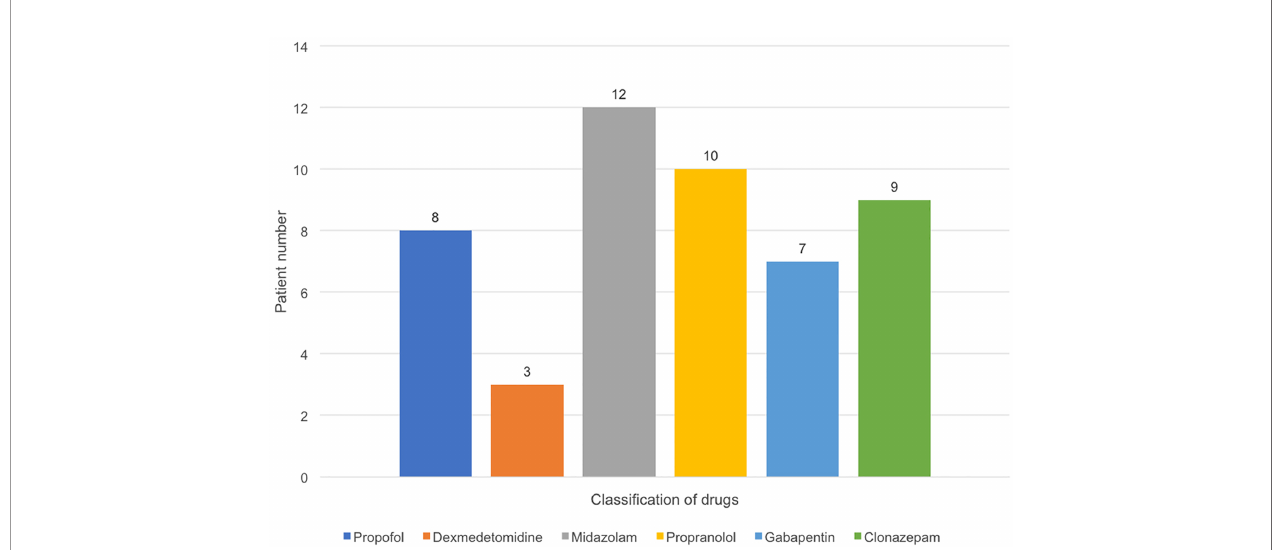
FIGURE 2 | Pharmacologic management in PSH (+) group. The most common intravenous treatment for acute symptom termination was midazol am (n = 12), followed by propofol (n = 8), and dexmedetomidine (n = 3). For chronic prevention, propranolol (n = 10) was the most common option, followed by clonazepam (n = 9) and gabapentin (n =